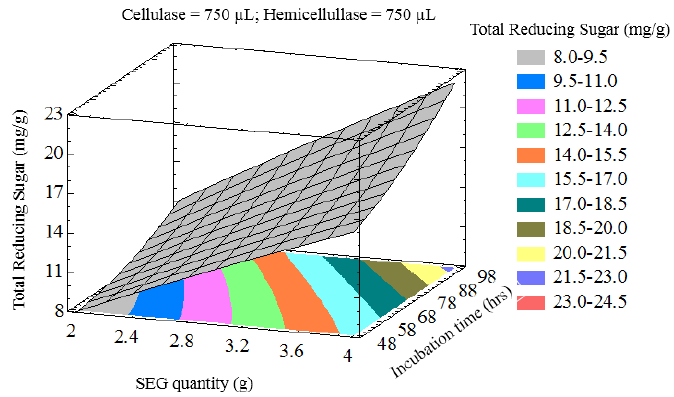
Figure 3. Three-dimensional response surface plot showing influence of SEG quantity (g) and incubation time (h) when the response surface is fixed at cellulase and hemicellulose loadings = 750 uL.